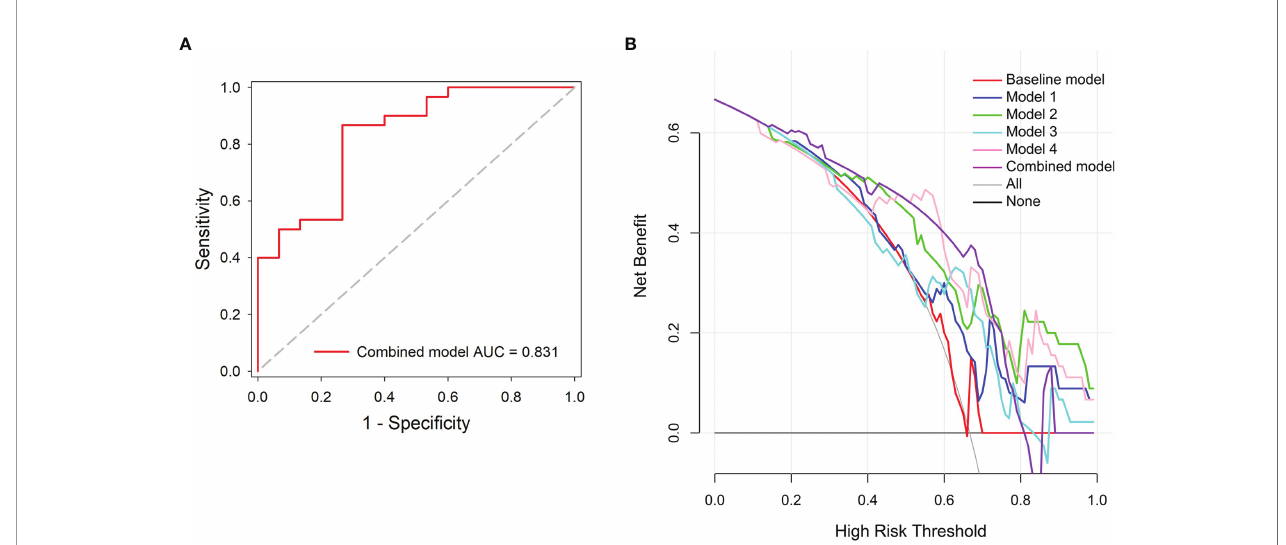
TABLE 2 | Performance comparison of the predictive models in the independent dataset.